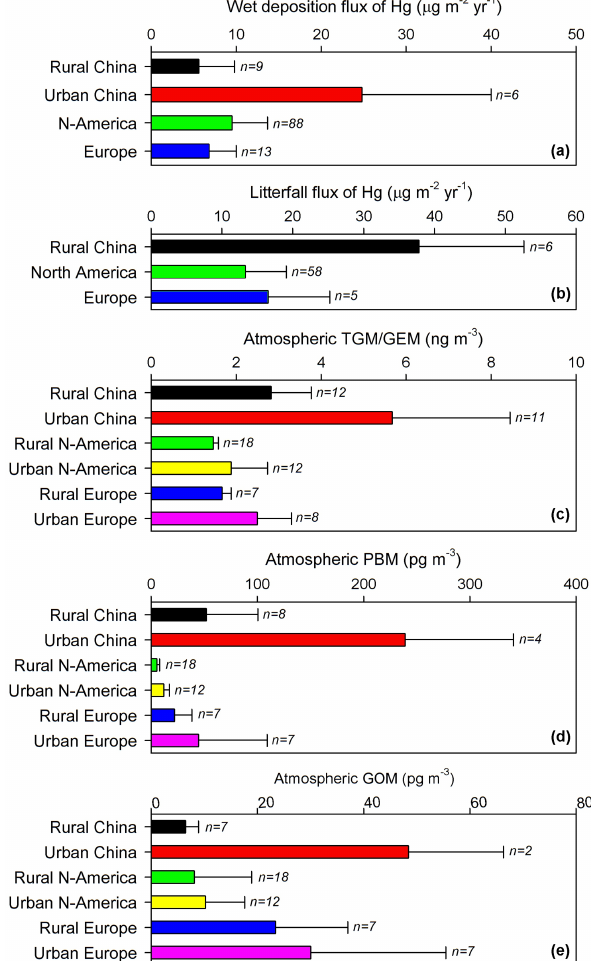
Figure 5. Comparison of (a) wet deposition flux of Hg; (b) lit- terfall deposition of Hg; (c) atmospheric total gaseous mercury (TGM)/gaseous elemental mercury (GEM) concentrations; (d) at- mospheric particulate bound mercury (PBM) concentrations; and (e) atmospheric gaseous oxidized mercury (GOM) concentrations between China and North America and Europe. Note that atmo- spheric PBM in Europe is referred to as total particulate bound mercury and in the remaining regions is referred to as particu- late bound mercury on particles with an aerodynamic diameter of <2.5µm. Data are from this study, the literature, and references therein (EMEP; Munthe et al., 1995, 2003; Lee et al., 2000; Schwe- sig and Matzner, 2000; St. Louis et al., 2001; Pirrone et al., 2003; Swartzendruber et al., 2006; Wang, 2006; Yatavelli et al., 2006; De- mers et al., 2007; Lindberg et al., 2007; Valente et al., 2007; Bushey et al., 2008; Choi et al., 2008; Larssen et al., 2008; Li et al., 2008; Fain et al., 2009; Peterson et al., 2009; Prestbo and Gay, 2009; Song et al., 2009; Wang et al., 2009; Engle et al., 2010; Sprovieri et al., 2010; Liu et al., 2011; Fisher and Wolfe, 2012; Fu et al., 2012b; Juillerat et al., 2012; Risch et al., 2012; X. T. Zhang et al., 2012; Chen et al., 2013; Zhu et al., 2014; Fu et al., 2015b, 2016; Ma et al.,